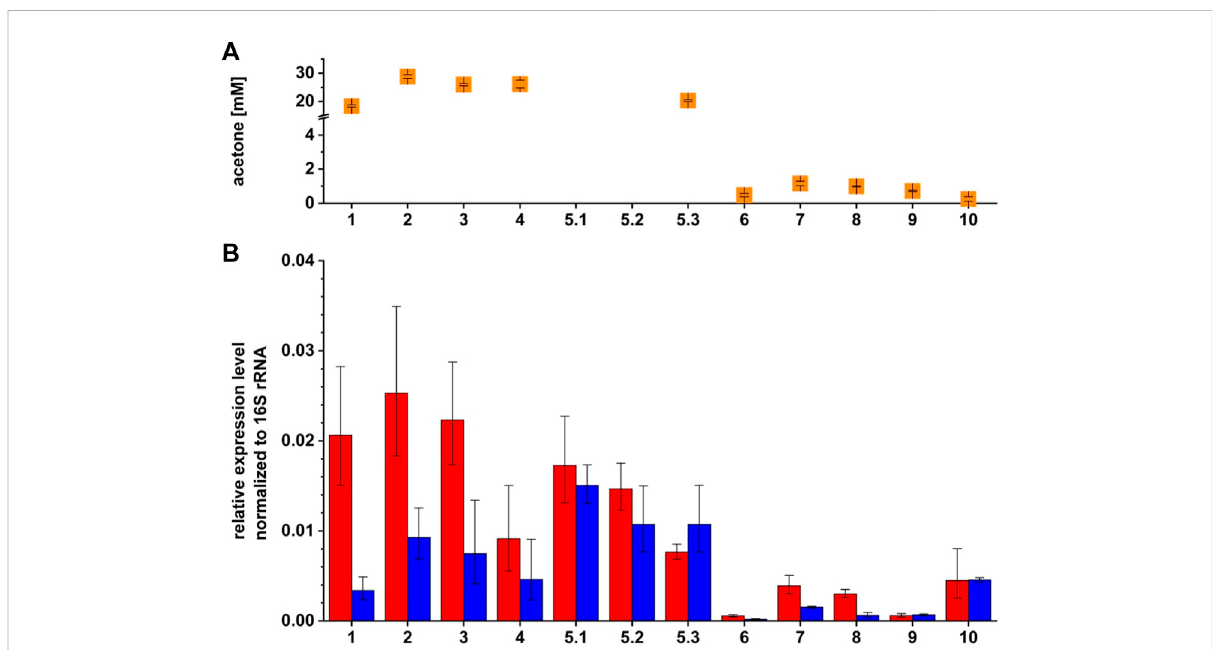
FIGURE 5 Maximalacetoneconcentrationsandrelativeexpressionlevelsof sol mRNAandAssolrnaofdifferent C . saccharoperbutylacetonicum strainsfor investigation of regulation by Assolrna. (A) orange squares, maximal acetone concentration measured for the respective strains; (B) red bars, relative expressionlevelof sol mRNA;bluebars,relativeexpressionlevelofAssolrnanormalizedtoexpressionlevelof16SrRNA.RNAwasextractedafter48 h of growth except for the wild type (1) because it reached the same growth phase faster than the other strains (after 34.5 h) and induced C . saccharoperbutylacetonicum [pMTL83151_ asr _P bgaL ](5)forwhichRNAwasextracted severaltimesafterinduction(19 hofgrowth).Thismeansthat all samples except for 5.1 and 5.2 were prepared from the same growth phase. Numbers represent strains of whichRNA was used for qRT-PCR. 1, C. saccharoperbutylacetonicum wild type; 2, C. saccharoperbutylacetonicum [pMTL83151]; 3, C. saccharoperbutylacetonicum [pMTL83151_Komp_P asr T]; 4, non-induced C . saccharoperbutylacetonicum [pMTL83151_ asr _P bgaL ]; 5.1, induced C. saccharoperbutylacetonicum [pMTL83151_ asr _P bgaL ],RNAisolated19 hafterinduction;5.2,induced C.saccharoperbutylacetonicum [pMTL83151_ asr _P bgaL ],RNAisolated25.5 h after induction; 5.3, induced C. saccharoperbutylacetonicum [pMTL83151_ asr _P bgaL ], RNA isolated 39 h after induction; 6, C . saccharoperbutylacetonicum Δ P asr :: P asr **; 7, C. saccharoperbutylacetonicum Δ P asr :: P asr ** [pMTL83151]; 8, C . saccharoperbutylacetonicum Δ P Δ P asr :: P asr ** [pMTL83151_Komp_P asr T]; 9, non-induced C . saccharoperbutylacetonicum asr :: P asr ** [pMTL83151_ asr _P bgaL ]; 10, induced C. saccharoperbutylacetonicum Δ P asr :: P asr ** [pMTL83151_ asr _P bgaL ]. Error bars represent standard deviations, n = 3. This fi gure is modi fi ed from